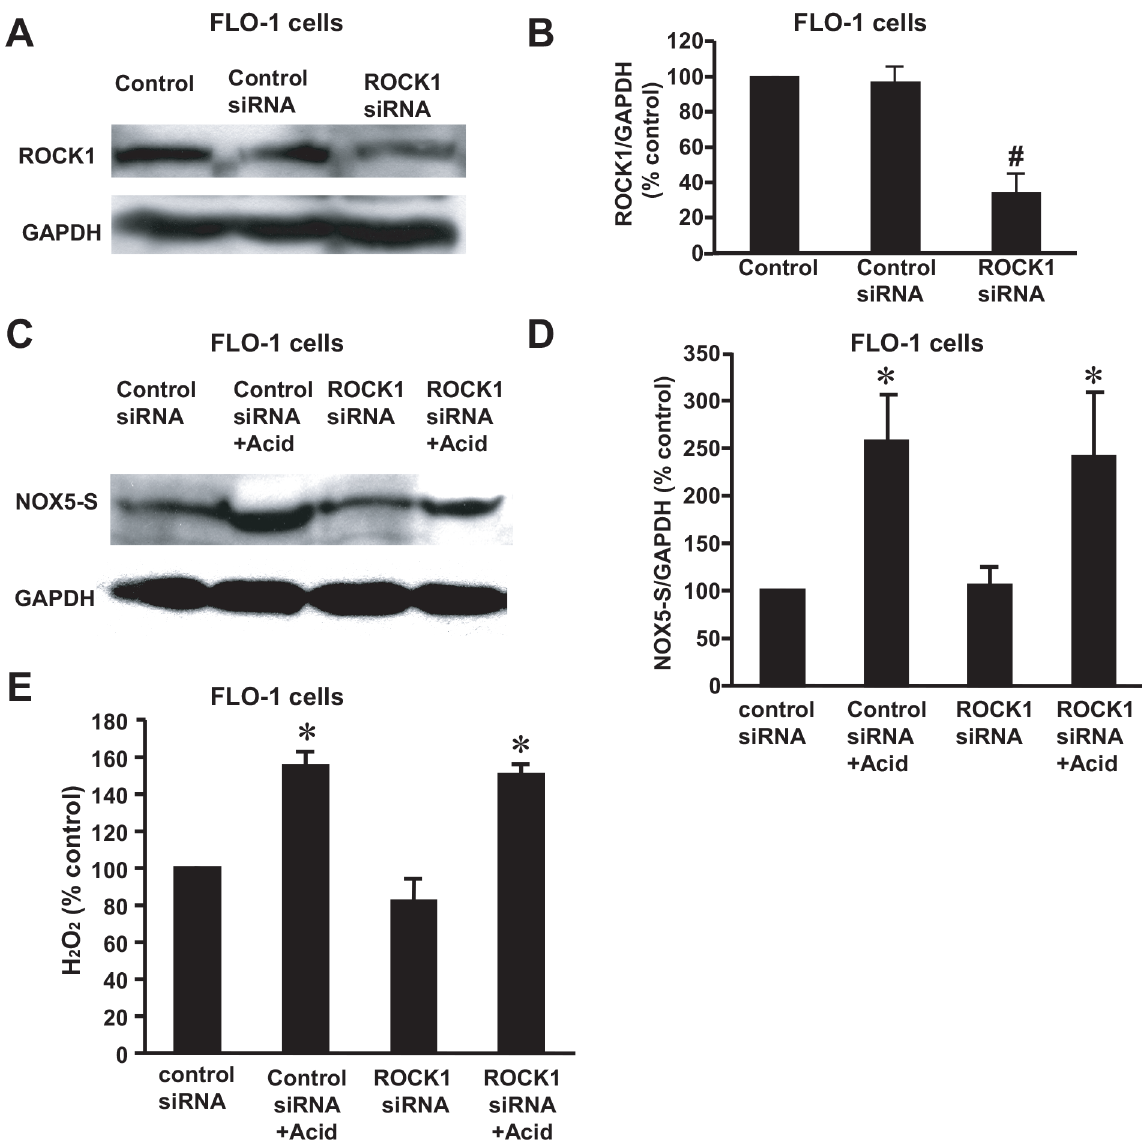
Fig 3. Role of ROCK1 in Acid-induced NOX5-S expression in FLO-1 EA cells. (A) A typical example of three Western blot analysis and (B) summarized data showed that transfection with ROCK1 kinase siRNA significantly decreased ROCK1 protein expression in FLO-1 EA cells, indicating that ROCK1 siRNA effectively down-regulated ROCK1 protein expression (n = 3). (C) A typical example of three Western blot analysis and (D) summarized data showed that knockdown of ROCK1 protein did not significantly affect acid-induced NOX5-S expression. (E) Knockdown of ROCK1 protein had no statistically significant effect on acid-induced H 2 O 2 production. The data suggest that ROCK1 may not be involved in acid-induced NOX5-S expression and H 2 O 2 production in FLO-1 EA cells. N = 3, ANOVA, * P < 0.05, compared with control siRNA group or ROCK1 siRNA group. There was no statistically significant difference between control siRNA+ acid group and ROCK1 siRNA+ acid group. # P < 0.05, compared with control or control siRNA